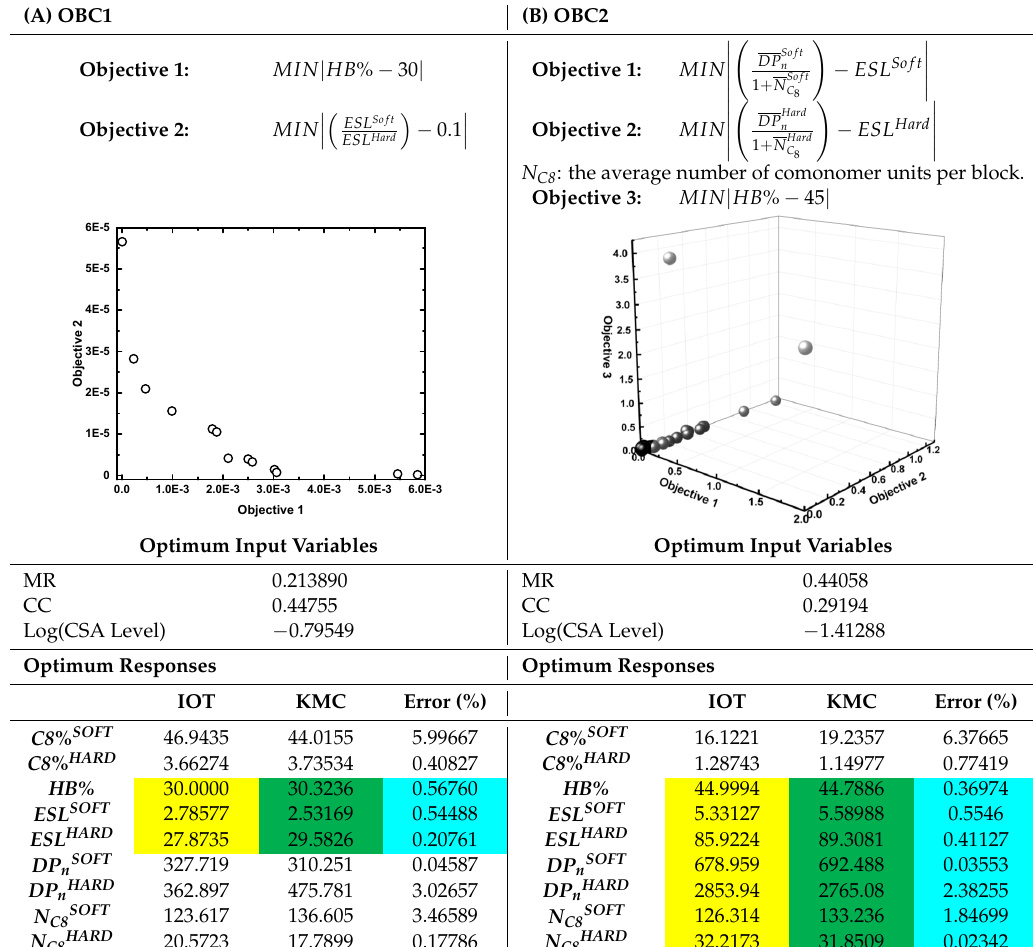
Table 2. The chain microstructure of the OBC1 and OBC2 macromolecules tailored using the IOT. The constraints/objectives used in the multi-objective optimization, Pareto fronts showing the best solution, and optimum input variables proposed by the IOT for the synthesis of OBC1 and OBC2 are provided. Microstructural features controlled by the IOT highlighted in yellow; KMC optimizer outputs obtained at identical optimum polymerization recipes highlighted in green; errors in the IOT predictions highlighted in Turquoise.